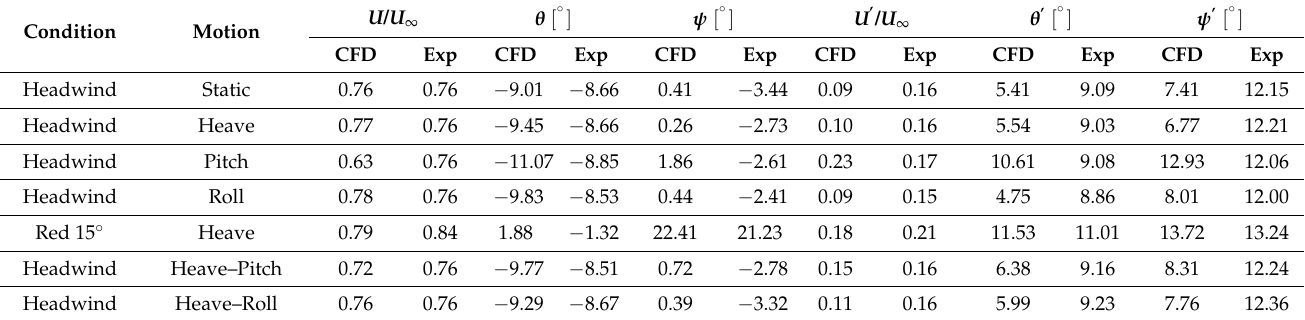
Table 6. Mean velocity and fluctuations of velocity in the airwake over the flight deck behind the CPF in motion, at location C5 in Figure 4b—the highest elevation (z = 9.5 m) of the centre probe (x = 14